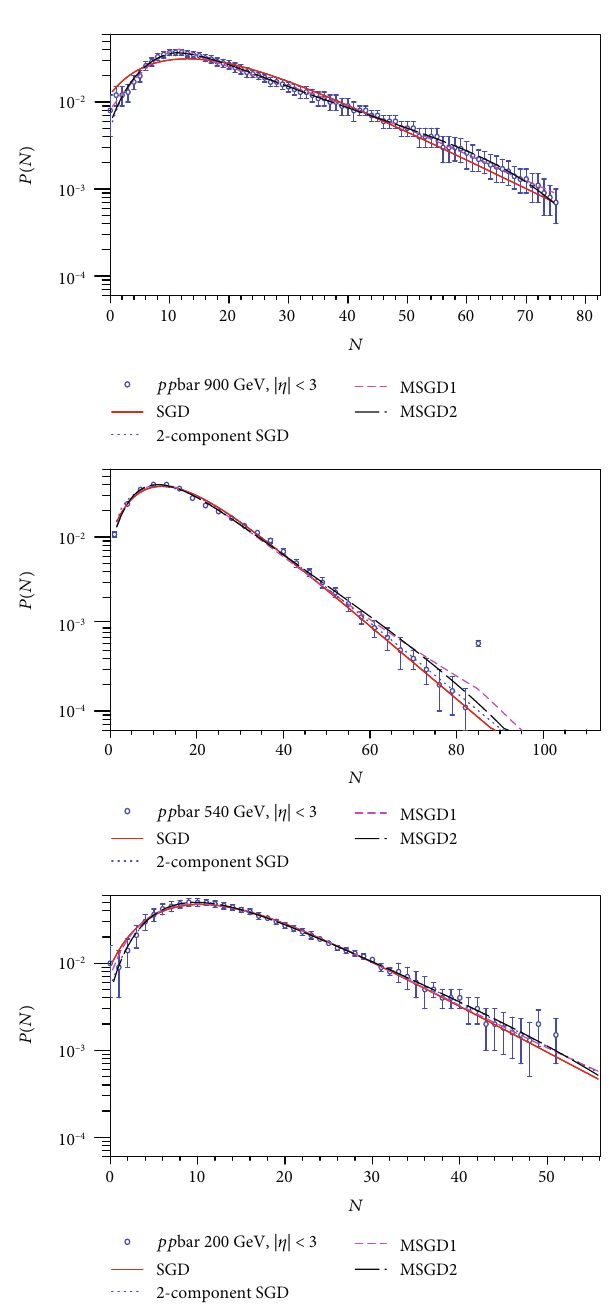
Figure 2: SGD, 2-component SGD, MSGD1, and MSGD2 distributions for p (cid:1) p collisions at di ff erent experiment for j η j < 3 : 0 .